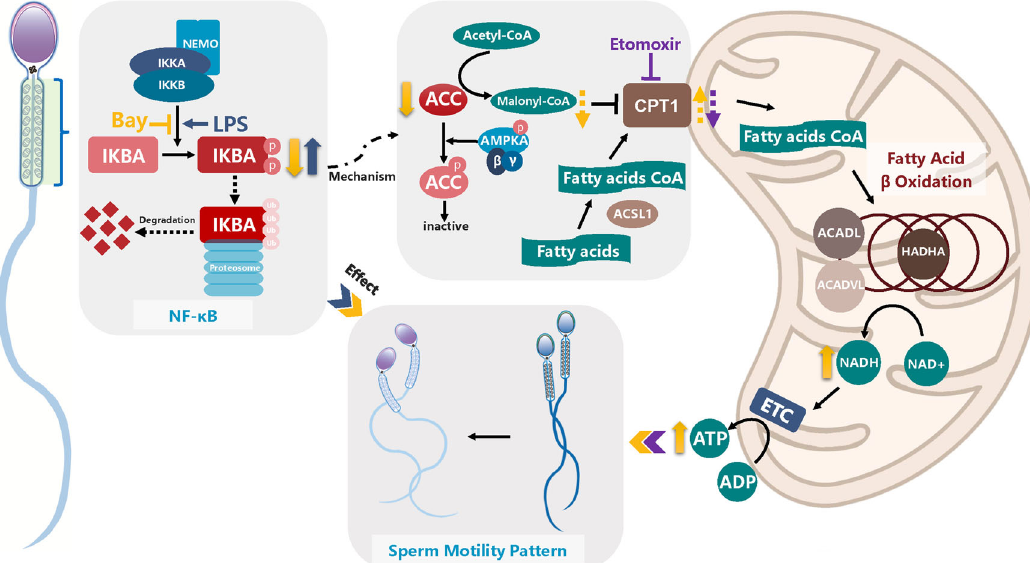
Fig. 8 Diagram depicting the regulation mechanism of IKBA phosphorylation in sperm motility. IKBA and IKK subunits located on the midpiece of human sperm. Bay117082 inhibits IKBA phosphorylation and changes the swimming pattern from forward movement to curvilinear movement. On the contrary, LPS induces IKBA phosphorylation and weakens sperm motility. ACC level decrease and pACC/ACC level shows an upward trend when sperm are treated with Bay117082; thus, less acetyl-CoA is catalyzed by ACC to form malonyl-CoA. As malonyl-CoA inactivates CPT1A, the decrease in ACC level or the increase in pACC/ACC level reduces malonyl-CoA production and promote the entry of fatty acids into the mitochondria for catabolism. The key enzymes of FAO, including ACSL1, ACADL, ACADVL, and HADHA, are located on the midpiece of human sperm. NADH levels are elevated in sperm treated with Bay117082, suggesting that increased ATP levels from FAO support increased sperm motility. Etomoxir decreases sperm motility and blocks the action of Bay117082 on sperm motility. Thin black arrows represent known positive physiological process. Thin black dashed arrows indicate a speculative process. Blocked lines represent repressive effect. Thick arrows (up or down) indicate the alteration of substance after treatment with Bay117082 (yellow), LPS (blue), and etomoxir (purple); solid lines represent veri fi ed trends and dashed lines represent conjectural trends. The elements “ sperm ” and “ mitochondria ” were modi fi ed from our previous article 62